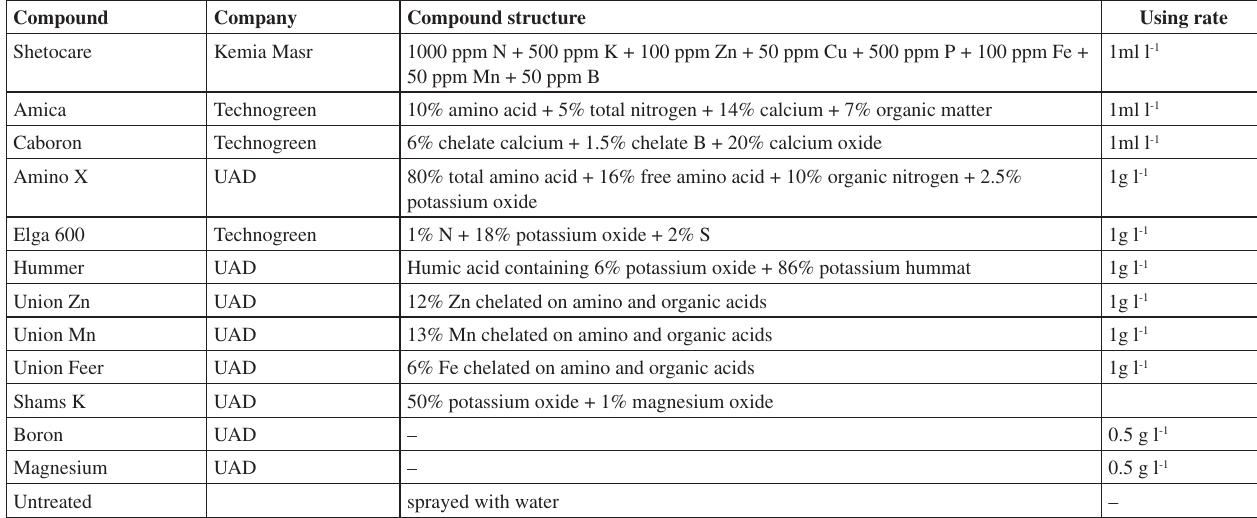
Table 1: Commercial compounds, their structures and using rate of them